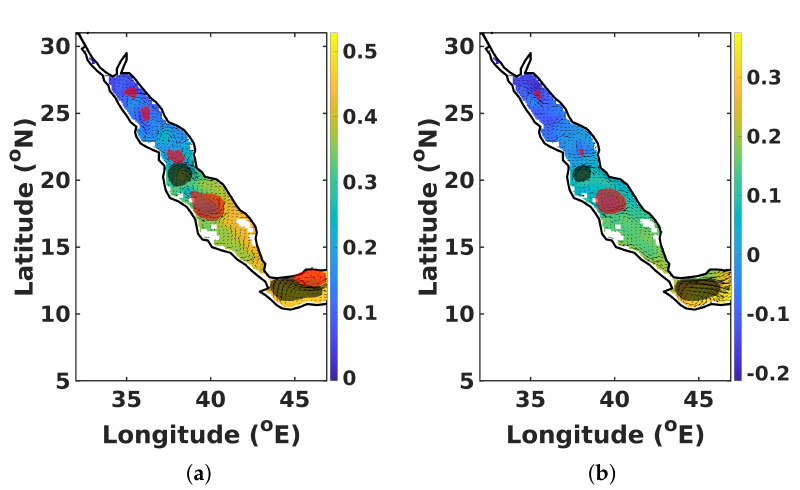
Figure 8. Red Sea Predictions: Predicted semantic-segmentation maps obtained using the fine-tuned ResNet50–FCN model. Since no ground-truth labels are available, we assessed the performance of the model without using any domain generalization to improve the predictions. Despite the facts that the network was not trained for the Red Sea and that the data for this narrow basin are coarse, the network is able to predict the rough locations of the mesoscale eddies. The plot shows the cyclonic eddies colored red and the anticyclonic eddies colored black. The scalar field shown in the plots corresponds to the SSH values in meters; ( a ) Sample 1; ( b ) Sample